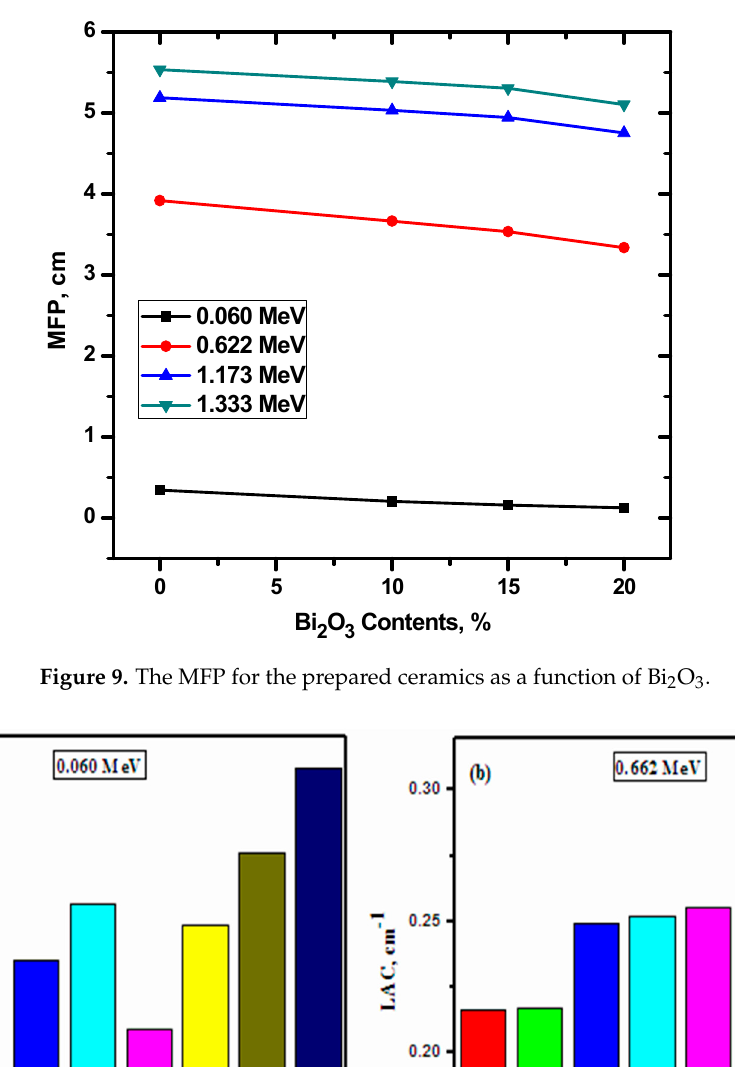
Figure 8. The HVL for the prepared ceramics as a function of Bi 2 O 3.